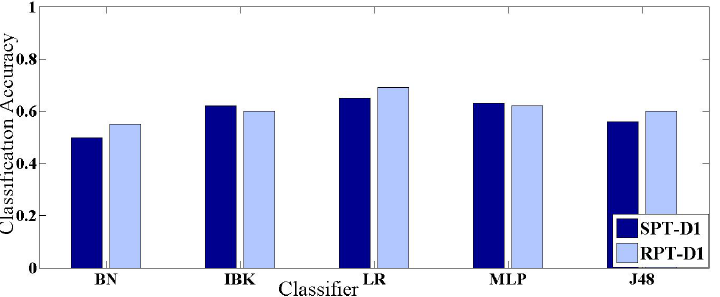
Figure 8. Base classifier selection in detailed activity recognition for SPT-D1 and RPT-D1 as training datasets and SPT-D5-Tst as test